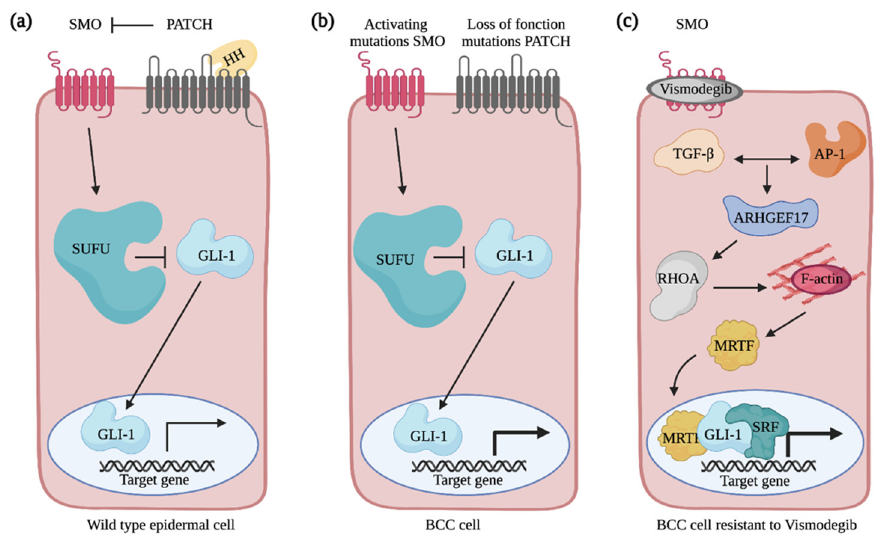
Figure 5. Overview of Hedgehog signaling pathway in normal and basal cell carcinoma cells. ( a ) The Hedgehog signaling pathway is activated when Hedgehog binds the PATCHED (PATCH) receptor. This relieves the inhibition on SMO by PATCH. By sending signals through a series of interacting proteins, including suppressor of fused (SUFU), SMO activates the downstream GLI family of transcription factors. ( b ) In BCC cells, SMO activating mutations or PATCH loss of function mutations amplify GLI transcriptional activity and promote the constitutive activation of the Hedgehog signaling pathway. ( c ) Non-canonical activation of GLI-mediated transcription in vismodegib-resistant basal cell carcinoma cell. TGF β and AP-1 signaling pathways promote ARHGEF17 expression that activates RHOA. By promoting actin polymerization, RHOA induces the translocation of MRTF in the nucleus and the formation of the MRTF-SRF complex that acts as a transcriptional cofactor for GLI to regulate a subset of target genes and to mediate resistance of the BCC cells to treatment. Created with BioRender.com, accessed on 20 August 2021.